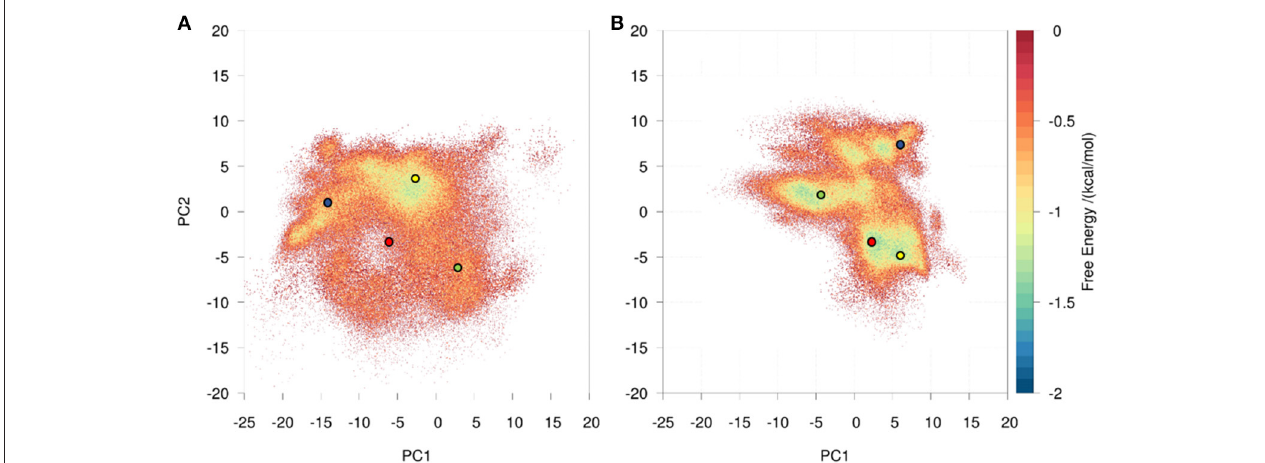
FIGURE 6 | Conformational space of the promiscuous Fab 249 (A) and the specific Fab 246 (B) antibody. Both 20 µ s trajectories are projected onto the combined PCA space, clearly showing that the specific antibody has more distinct and narrower free energy basins, while the promiscuous system shows a shallow and broad free energy surface. The PCCA + cluster representatives are illustrated as circles color-coded according to the Markov-state model in Figure 7 . The variances for the PC1 and PC2 are 58 and 13% respectively.